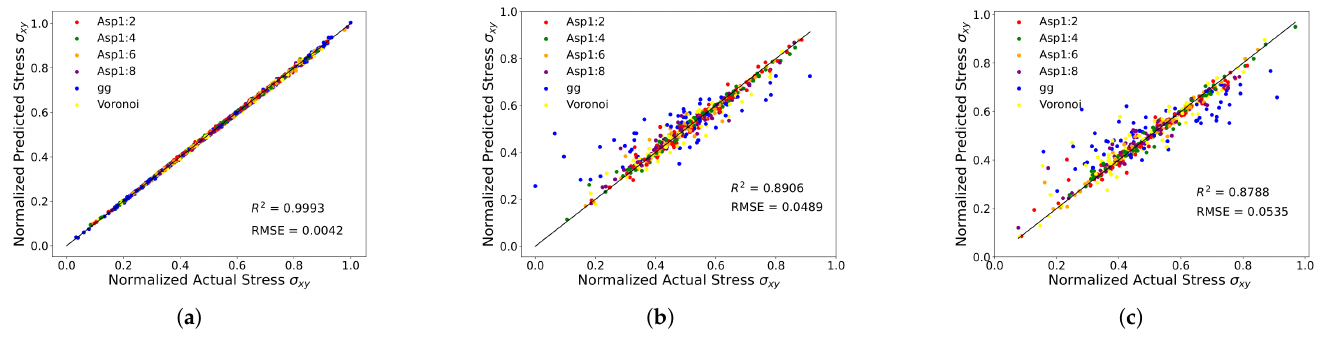
Figure A2. NN model prediction of normal stress σ xy for ( a ) training data ( b ) validation data ( c ) test data. The solid line represents the line of ideality. Asp1:2, Asp1:4, Asp1:6, Asp1:8 and gg represents columnar grain structure of aspect ratio 1:2,1:4,1:6,1:8 and grain growth structure,